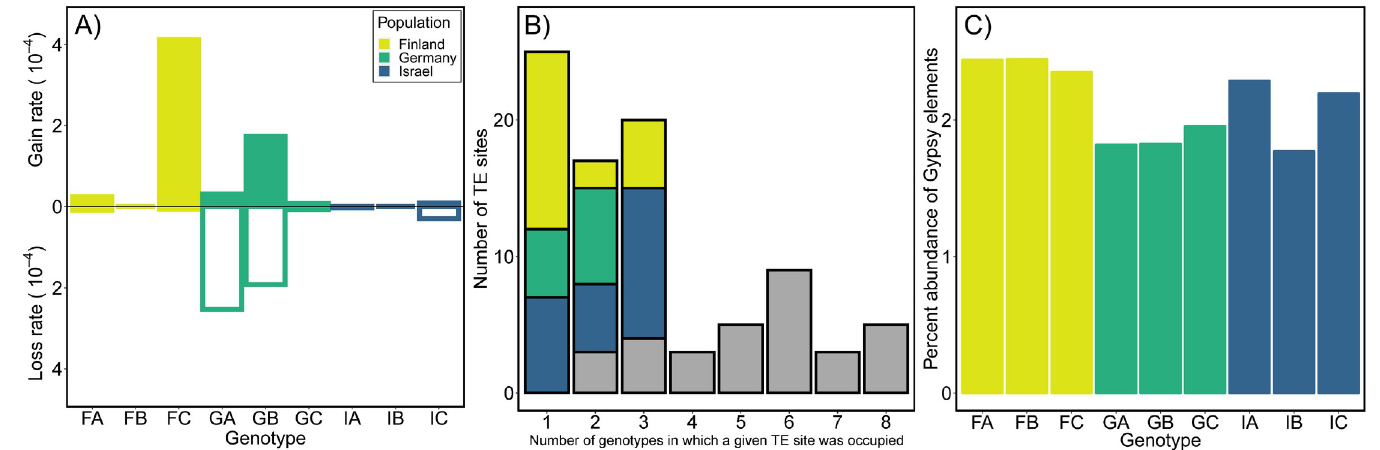
Fig 5. Rates of insertion site polymorphism and abundance for Gypsy family TEs in 9 genotypes of D . magna from Finland (gold), Germany (green), or Israel (blue). (A) Mean gain and loss rates (per copy per generation) for each genotype. Gain rates for FB, IA, IB and loss rates for FB, IB are zero. (B) Colored bars indicate the number of genotype-specific polymorphic sites (singletons; x = 1) or population-specific sites (when x = 2 and x = 3), grey bars represent sites where elements are shared across populations (reference genome used for this analysis was FASC). (C) Percent abundance in the genome for each genotype estimated using RepeatMasker.